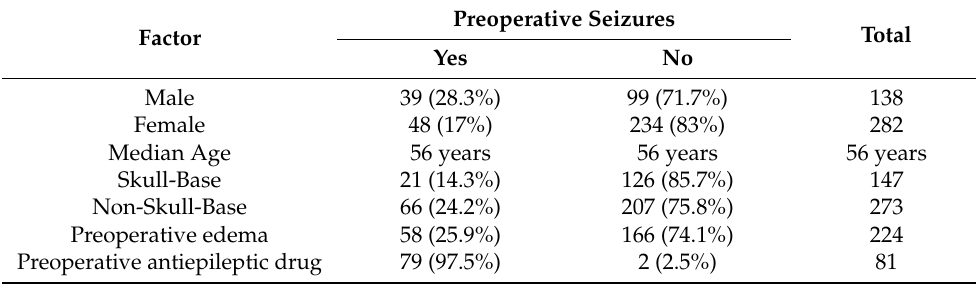
Table 1. Preoperative patient